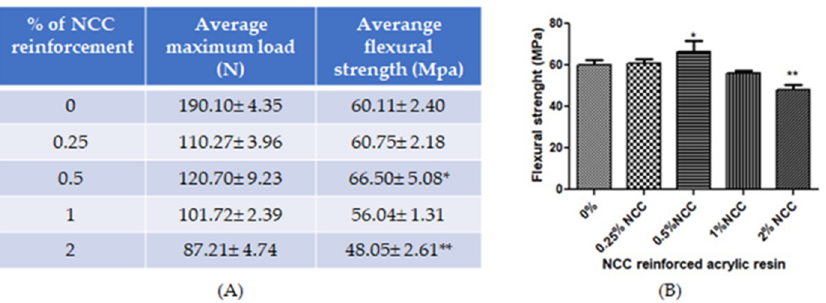
Figure 5. ( A ) The average and SD of maximum load and fractural strength of NCC-reinforced acrylic resin ( B ) The graph of the average and SD fractural strength of NCC-reinforced acrylic resin * p < 0.05,** p < 0.005 vs. 0% (N = 7).